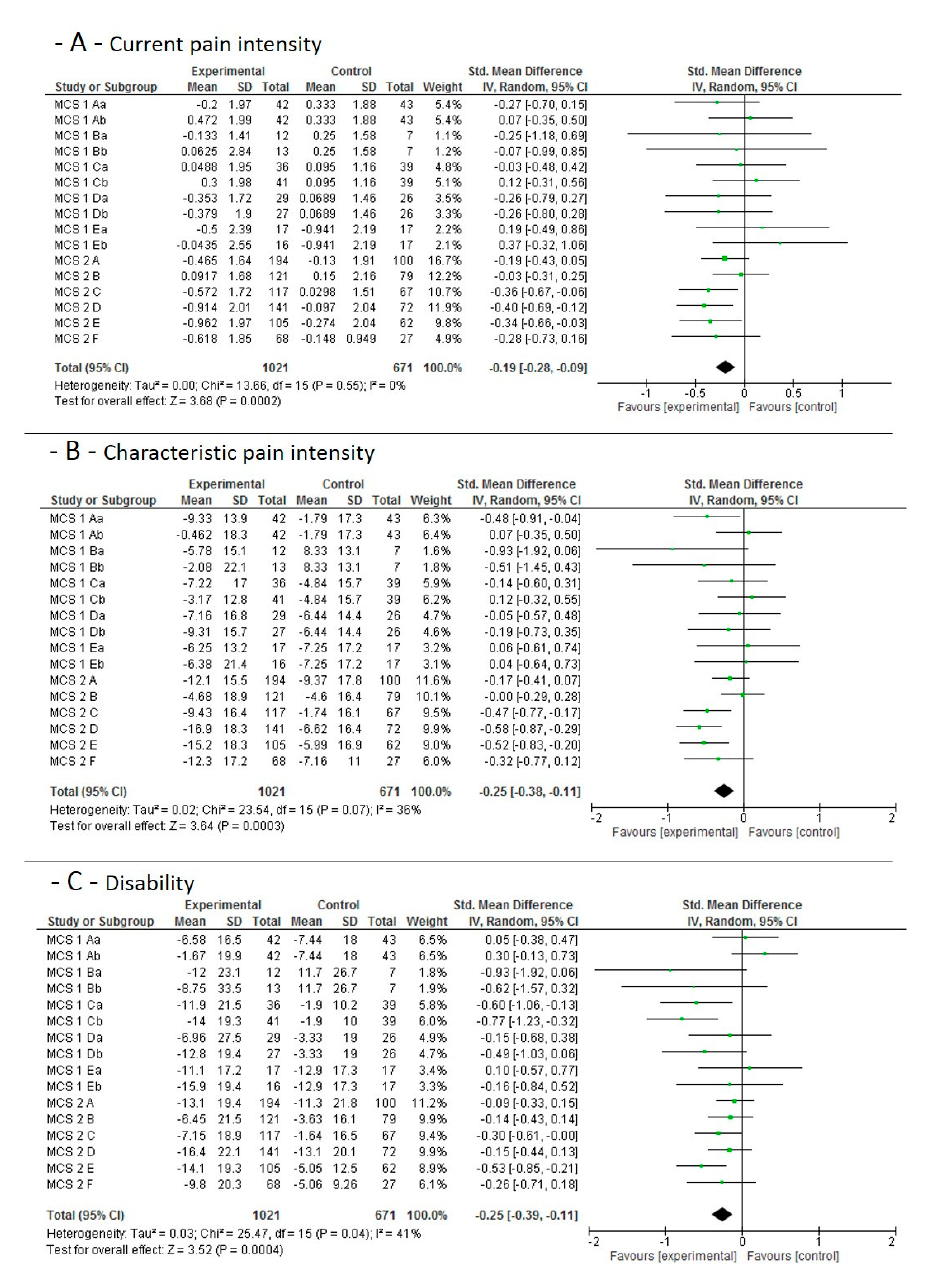
Figure 4. Data and Forest plots for the pooled outcome estimates for the long-term/sustainability effects of motor control stabilisation exercise vs. no additional exercise. ( A ): current pain intensity; ( B ): characteristic pain intensity; ( C ): disability. MCS equals multicenter study; SCS equals single-center study, A–F are the single study sites; a stands for MCE, b for MCE + behavioral. SD, standard deviation; P, p -value; IV, inverse variance; CI, confidence intervals; experimental, motor control stabilisation